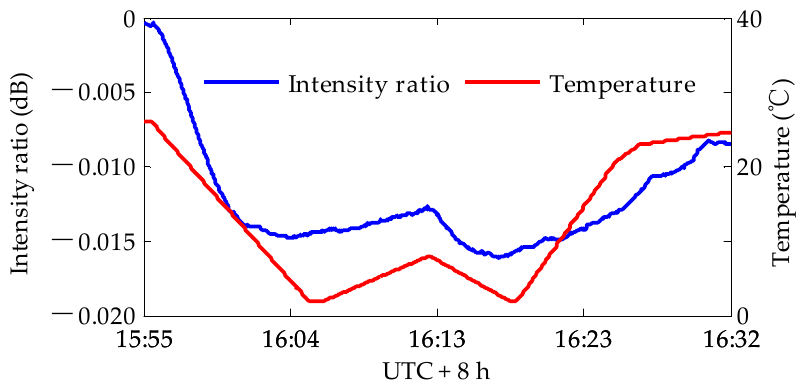
Figure 7. The results of the intensity ratio with the temperature changes between 2 °C and 25 °C in the monitoring photodetector .